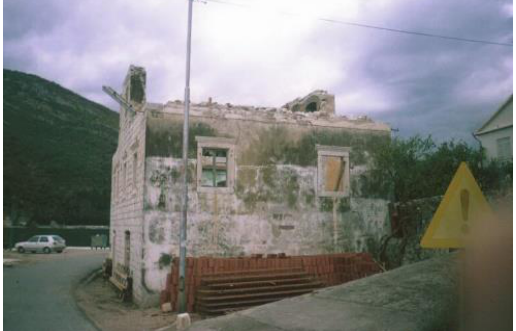
Figure 30. Captain’s house dating from 1842, before and at the beginning of reconstruction.